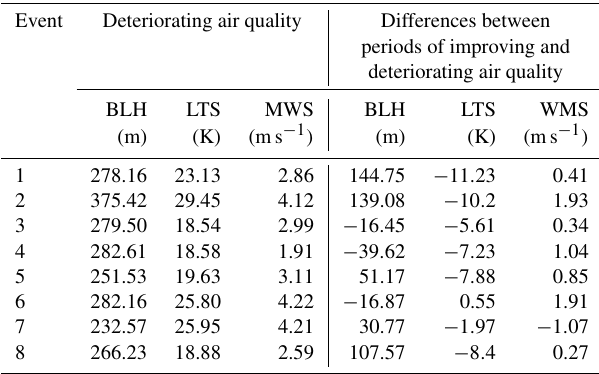
Figure 10. Vertical profiles of temperature at Wenjiang station (30.75 ◦ N, 103.875 ◦ E) measured by a radiosonde during periods of improving air quality for events 6 and 7.